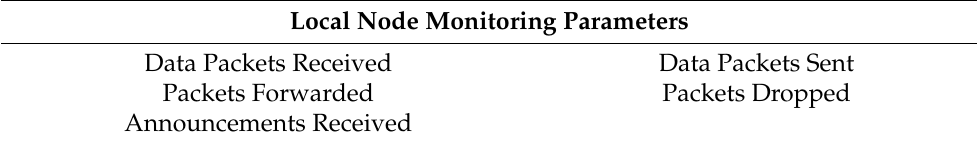
Table 1. Routing layer parameters used as input in the SVM models.